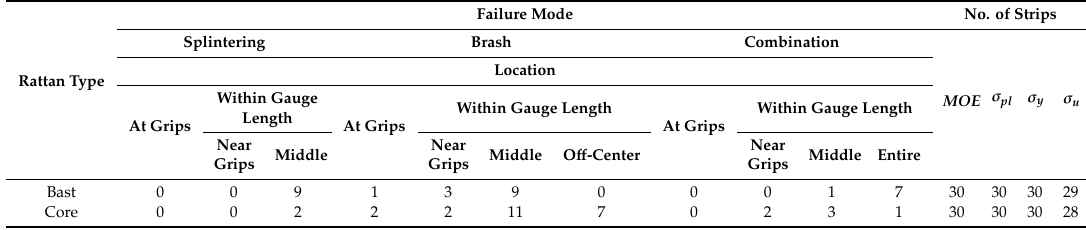
Table 2. Summary of numbers of natural rattan strips failed at each of major failure locations within each of three tensile failure modes observed in test 1 and numbers of the strips used for calculation of each of four tensile properties, strength at the proportional limit ( σ pl ), strength at yield point ( σ y ), strength at ultimate point ( σ u ), and modulus of elasticity